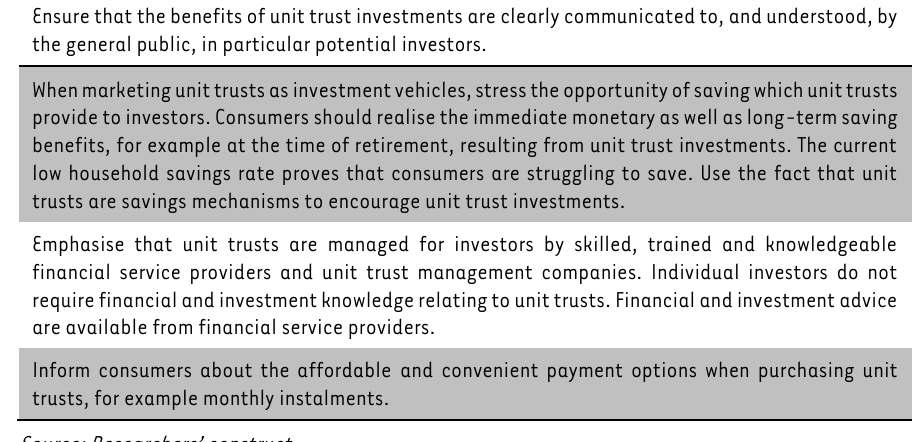
TABLE 8: Strategies to ensure consumers’ awareness of unit trust